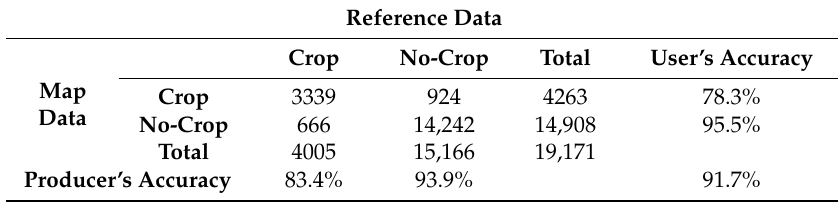
Table 13. The error matrix showing the overall accuracy of the GFSAD30m cropland extent